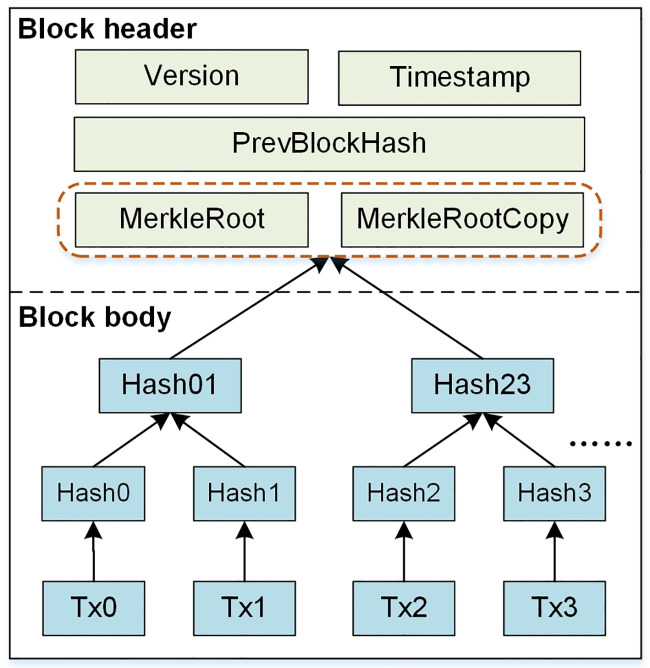
New block structure.